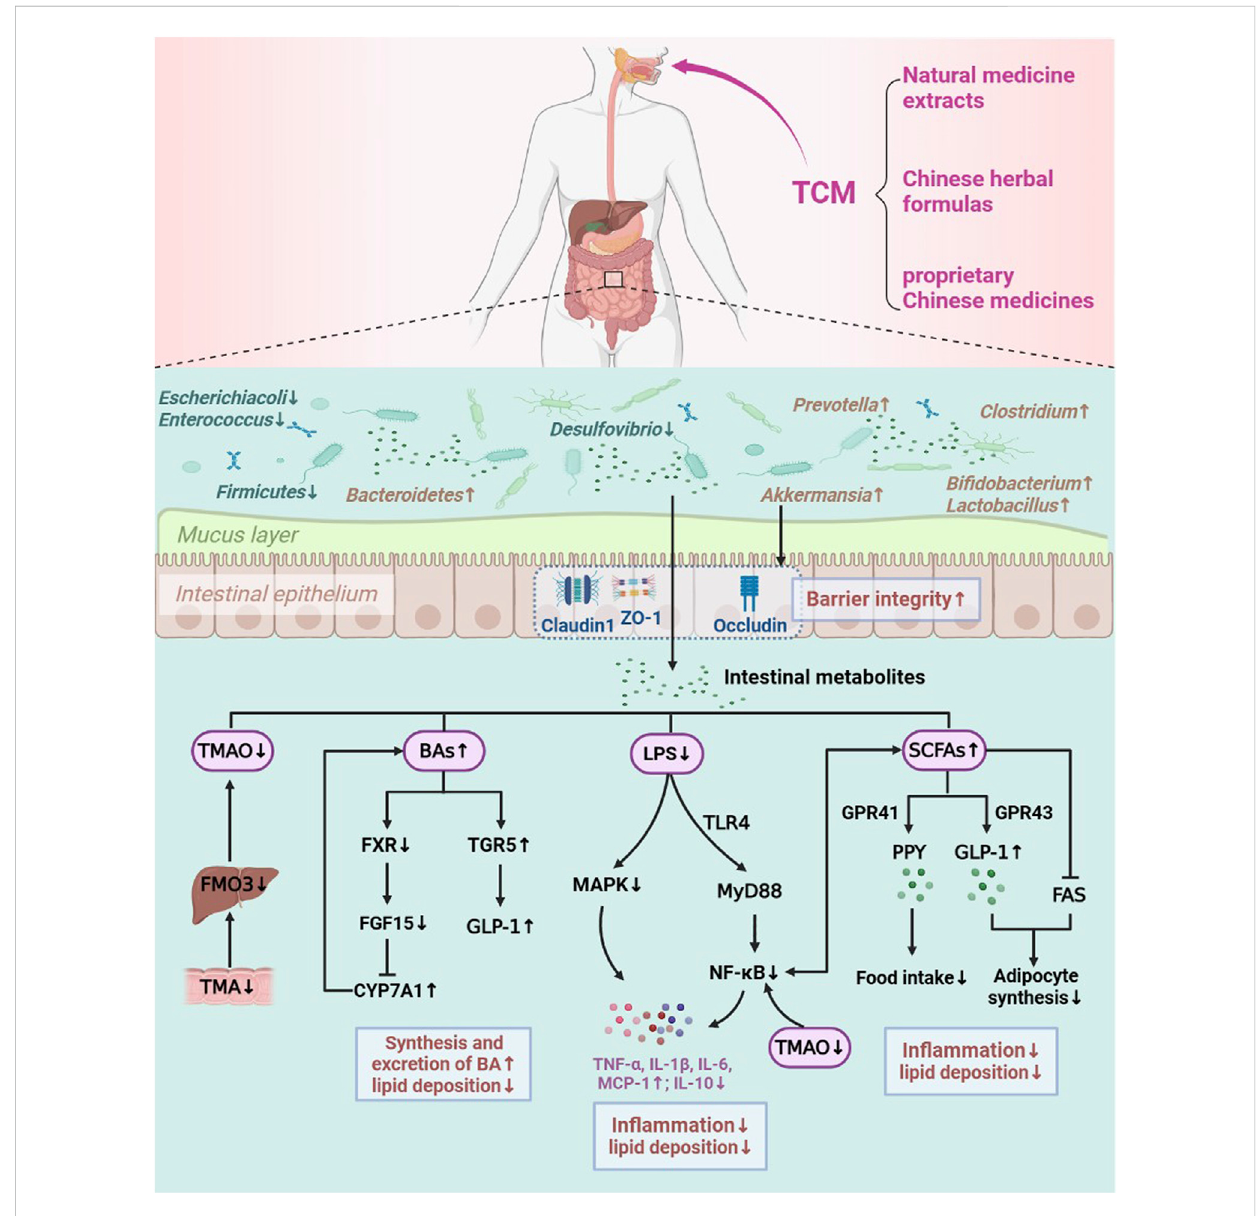
Mechanisms of TCM in improving LMD by regulating the intestinal fl